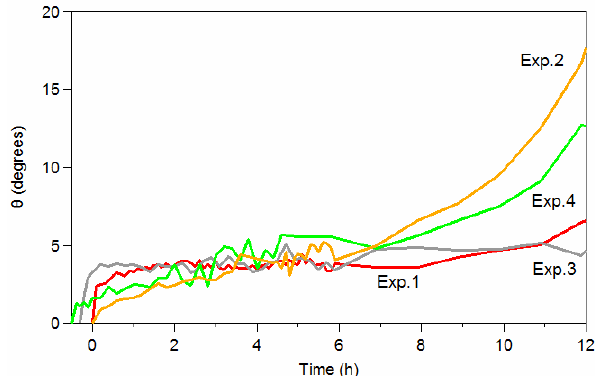
Fig. 6. Angle θ between the initial organic mass spectrum and Figure 6. Angle θ between the initial organic mass spectrum and the organic mass spectra throughout the whole experiment for the experiments 1-4 versus time. For the organic mass spectra throughout the whole experiment for the experiment 2, where the initial ozone concentration is higher, the oxidation is stronger experiments 1–4 versus time. For experiment 2, where the initial and the angle between the initial and the final mass spectrum is higher in comparison with the other experiments. ozone concentration is higher, the oxidation is stronger and the an- gle between the initial and the final mass spectrum is higher in com- parison with the other